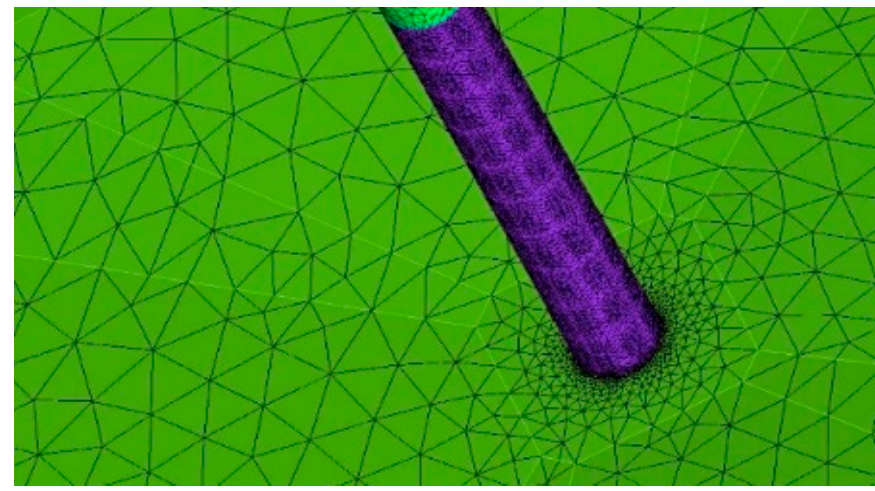
Figure 3. Inlet pipe grid distribution diagram.